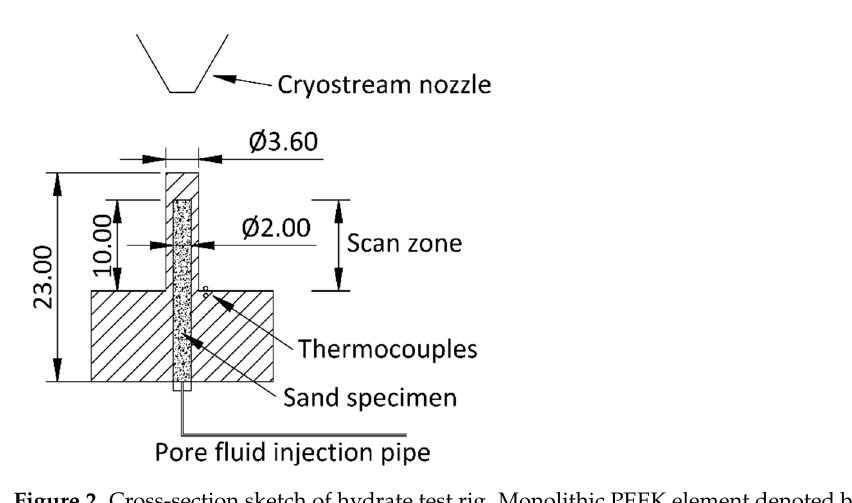
Figure 2. Cross-section sketch of hydrate test rig. Monolithic PEEK element denoted by hatched area. All units mm.